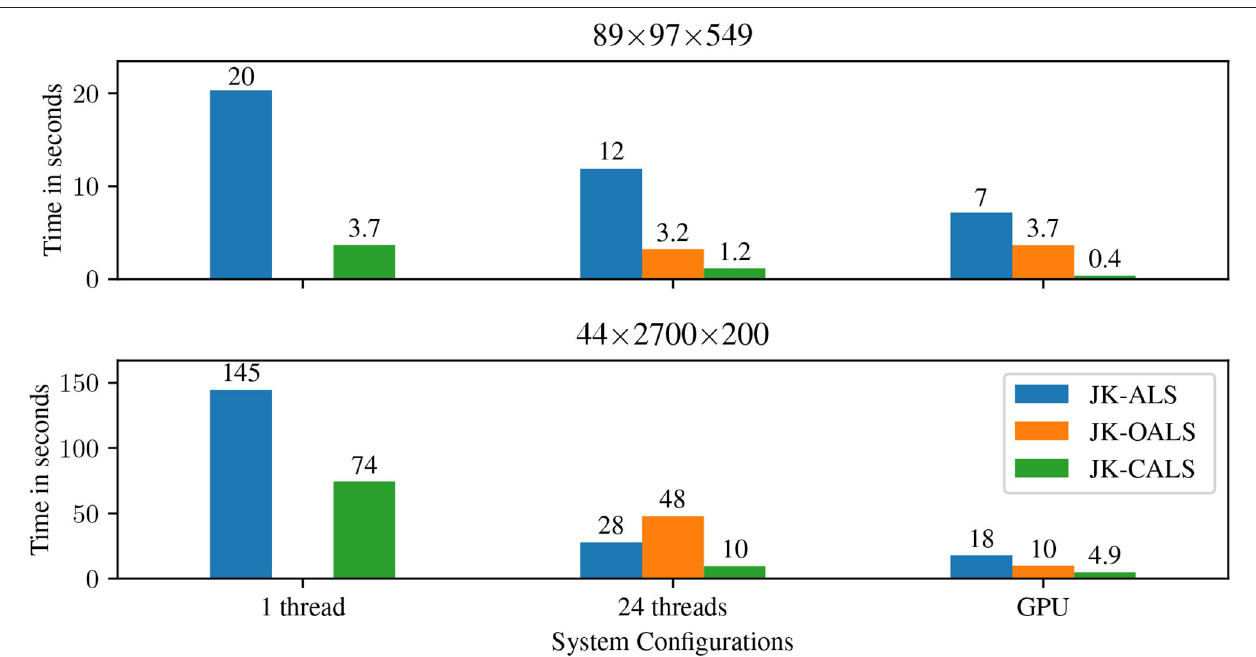
FIGURE 5 | Execution time for jackknife resampling applied to two applications tensors. For tensor 89 × 97 × 549, whose expected rank is 5, three models with R ∈ { 4,5,6 } were fitted and then jackknife was applied to them (i.e., the “All” group from the previous section). Similarly, for tensor 44 × 2,700 × 200, whose expected rank is 20, three models with R ∈ { 19,20,21 } were fitted and then jackknifed. In both cases, tolerance and maximum number of iterations were set to 10 − 6 and 1,000,